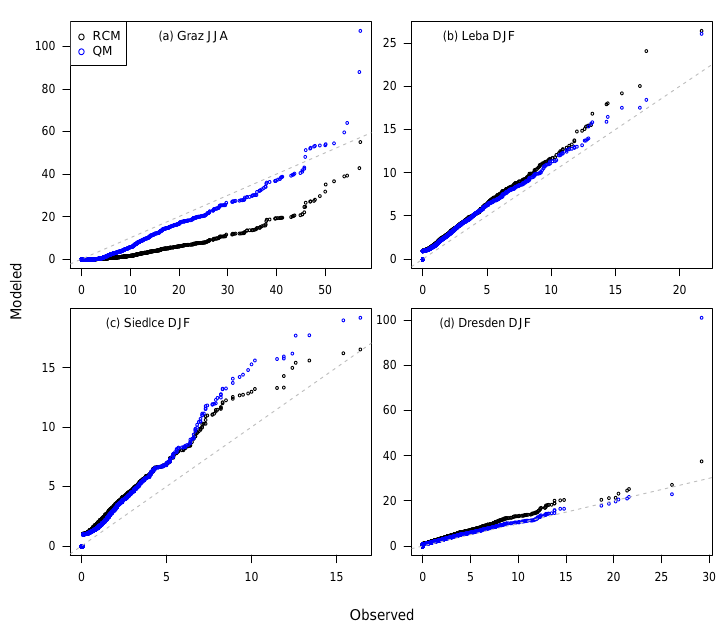
Figure B1. Step 1: bias correction to grid scale. QQ plots of RCM-simulated and QM grid -corrected (cross-validated) precipitation (mmday − 1 ) against E-OBS for stations with a high CvM score. (a) Graz JJA, (b) Leba DJF, (c) Siedlce DJF, and (d) Dresden